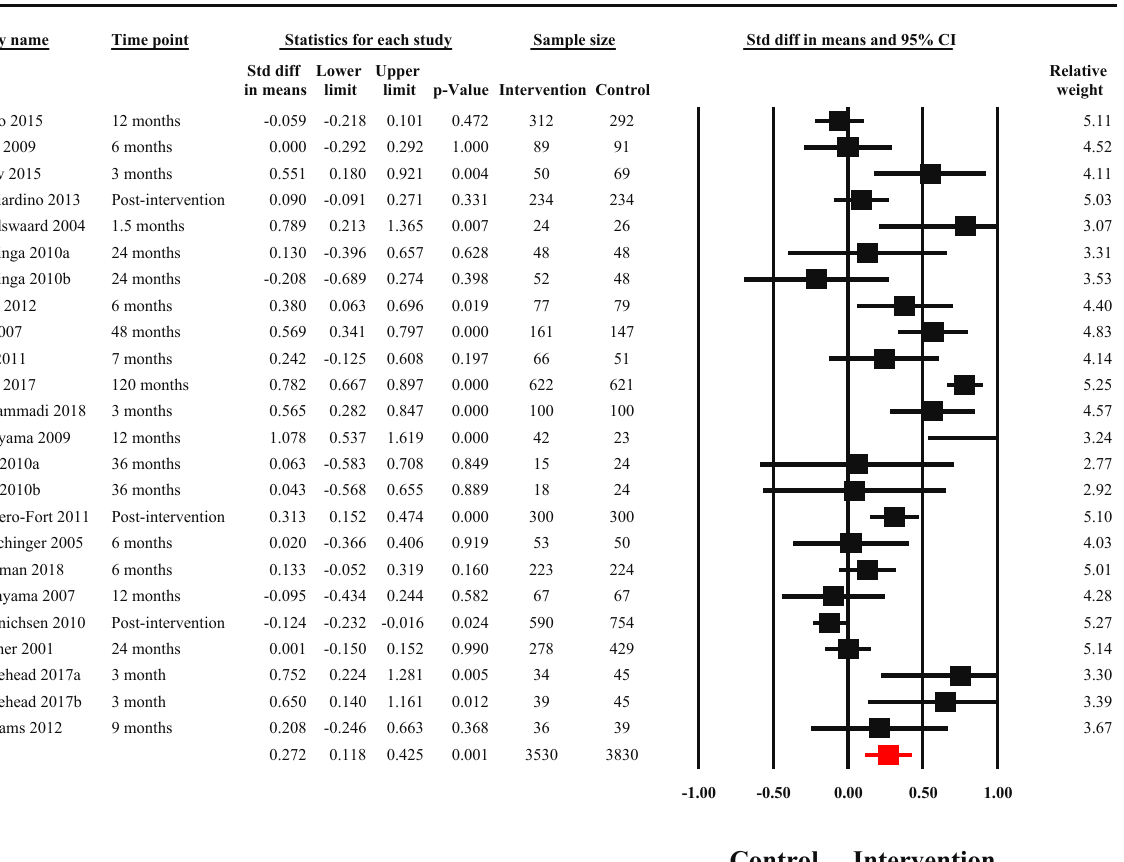
Figure 4. Effectiveness of TPE interventions in improving serum HbA1c levels among patients with diabetes mellitus. The black blocks present point estimates and 95% confidence intervals for individual studies. The red block presents pooled effect size and associated 95% confidence intervals